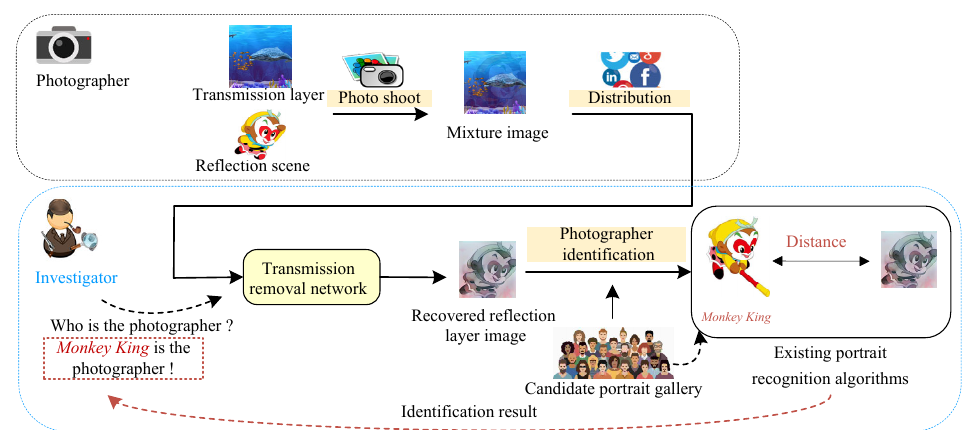
Figure 5. Schematic diagram of an application scenario for photographer identification.